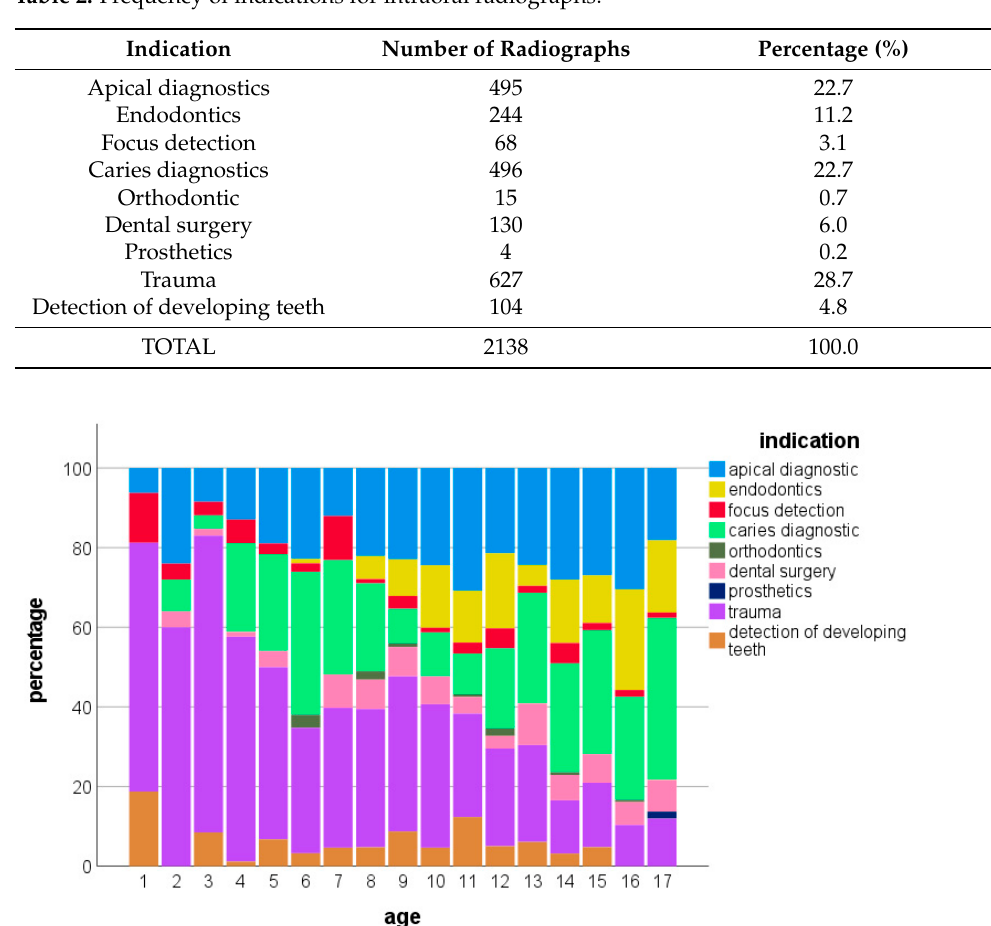
Table 2. Frequency of indications for intraoral radiographs.